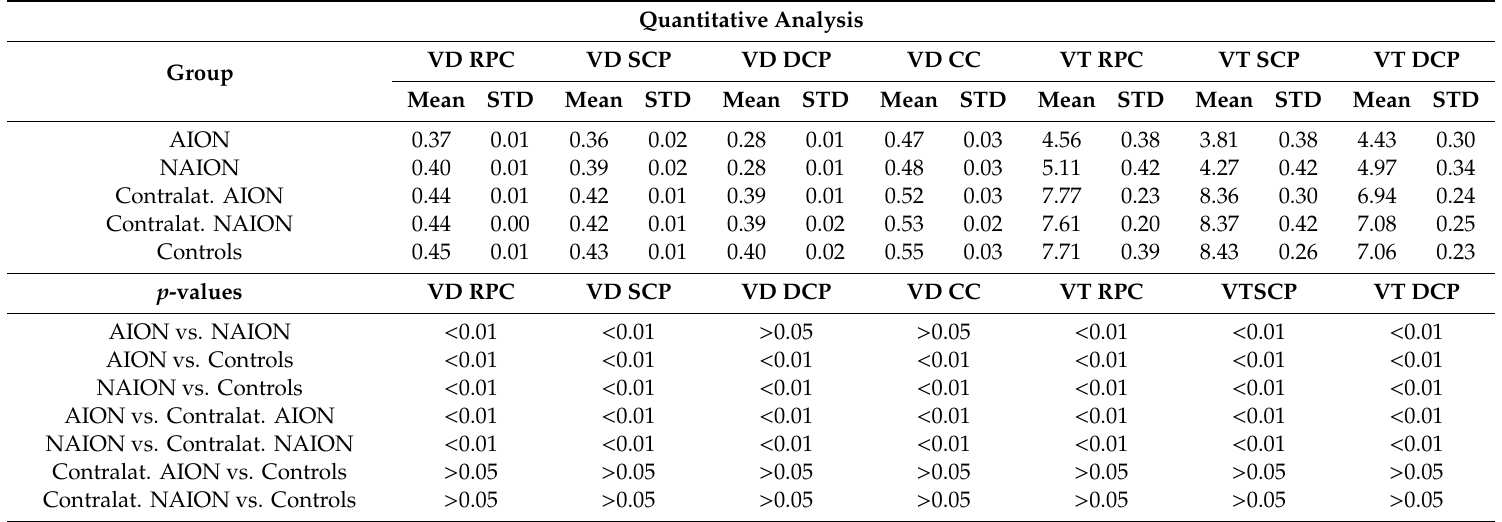
Table 1. Quantitative optical coherence tomography angiography (OCTA) analysis in anterior ischemic optic neuropathies. Quantitative